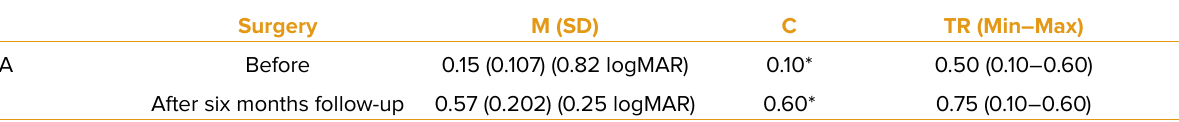
Table 2. Arithmetic mean and associated standard deviation, median and total range of at least to the highest value for variables of best-corrected visual acuity (BCVA) before and after surgery (six months follow-up) * P <